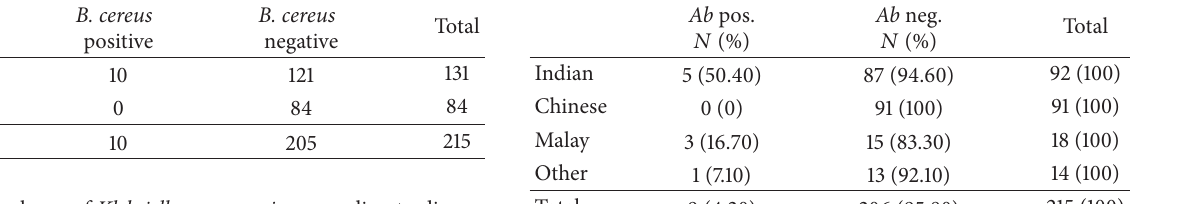
Table 5: Prevalence of Klebsiella pneumoniae according to disease group.